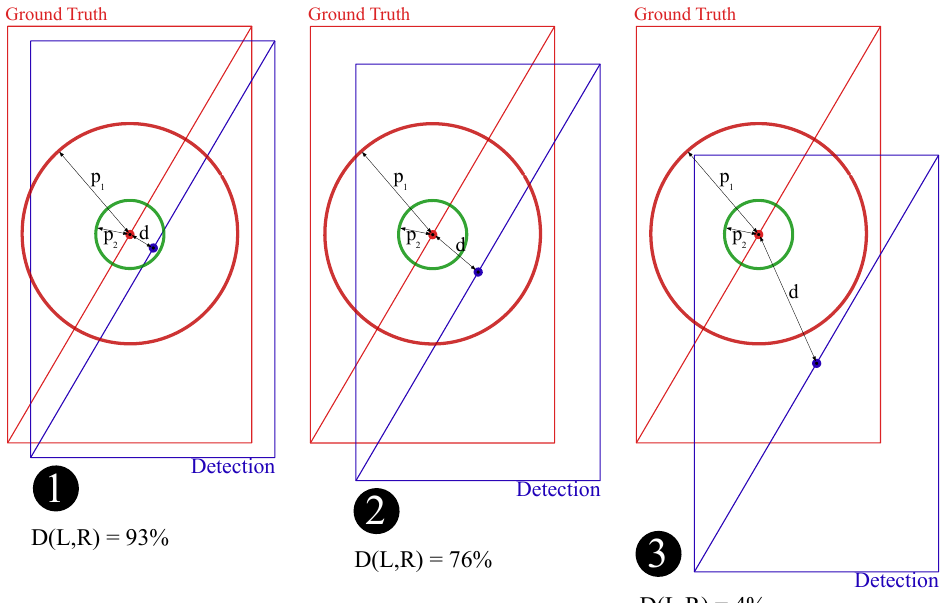
Figure 1. Distance similarity represents the difference in the position of rectangles rooted in the context of sizes of compared